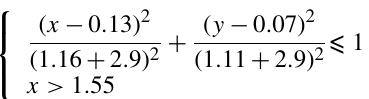
(sqrt = square root), the result shows that any point on the abdominal wall can be used as a candidate incision. The candidate incisions are located on the curve, as shown in Eq. (13). According to Sect. 3.4, the projection of the curve